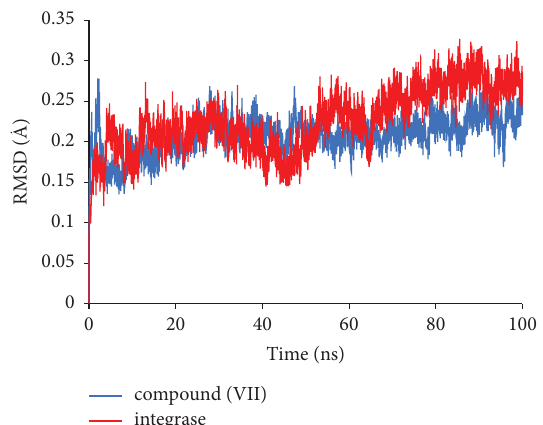
Figure 6: RMSD of alpha carbon of the integrase are shown as function of the simulation time (100ns) at 300K and the overlayed RMSD plots are integrased in red and compound VII in blue.